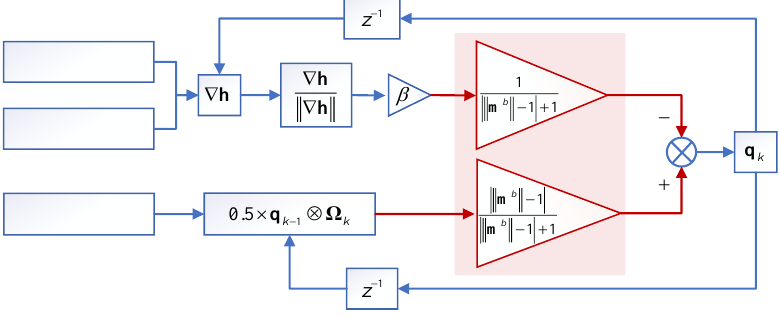
Figure 2. Diagram of AGDA for pedestrian initial alignment.